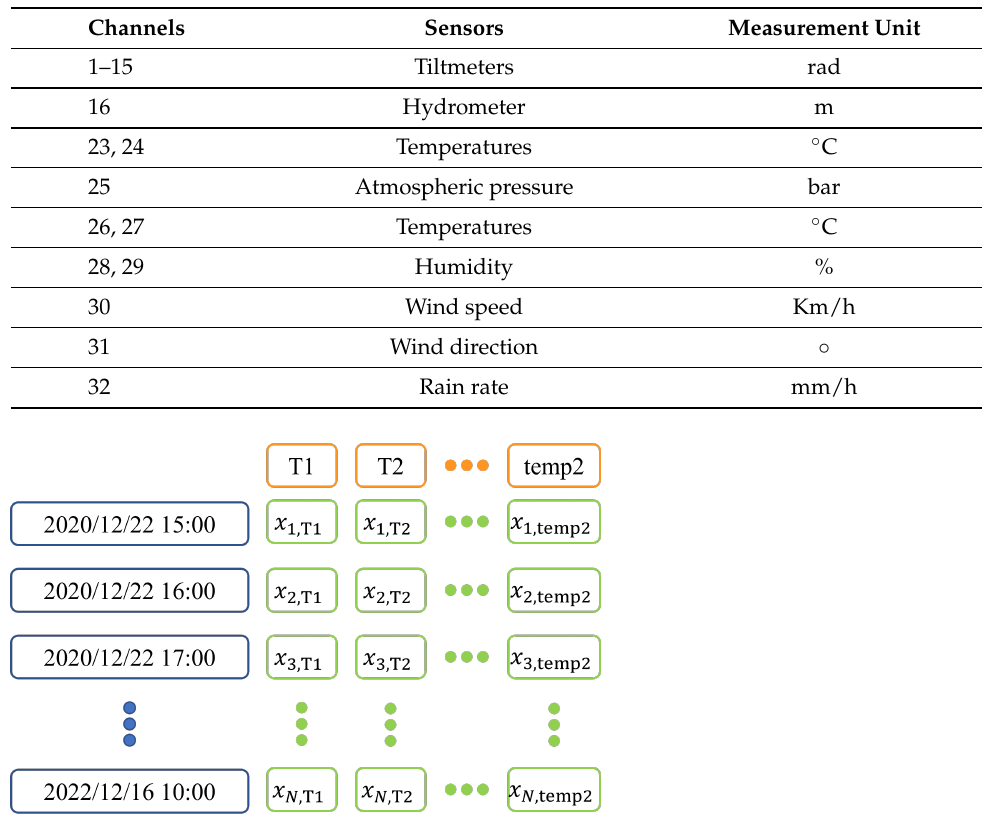
Table 1. Channels, sensors and measurement units of the acquisition system mounted on Can- dia Bridge.